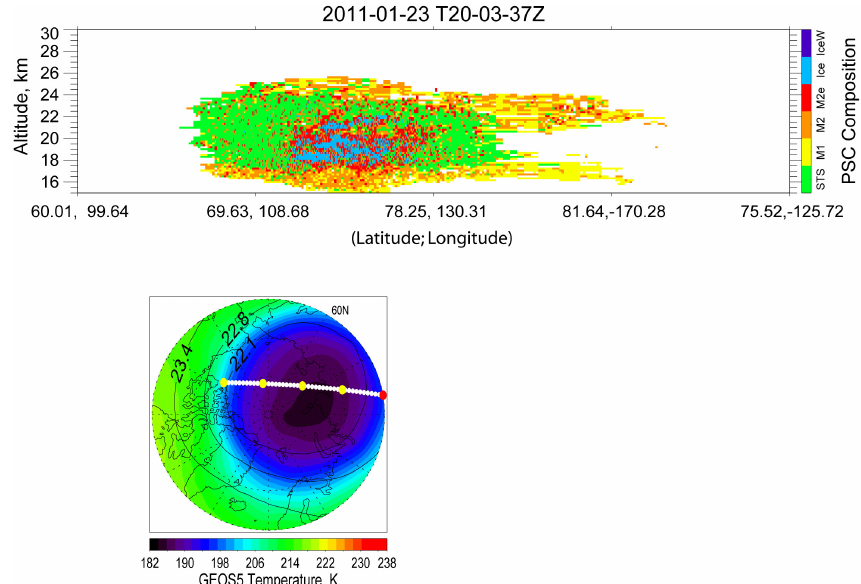
Figure 4. CALIPSO PSC composition for the PSC observation along the orbit track starting at 23 January 2011, 19:52UTC. Shown is the composition for the measurement on 23 January 2011 at 20:03UTC (top) and the GEOS-5 temperatures and geopotential height fields (in gpkm) at 30hPa at 12:00UT (bottom). The white line marks the CALIPSO orbit